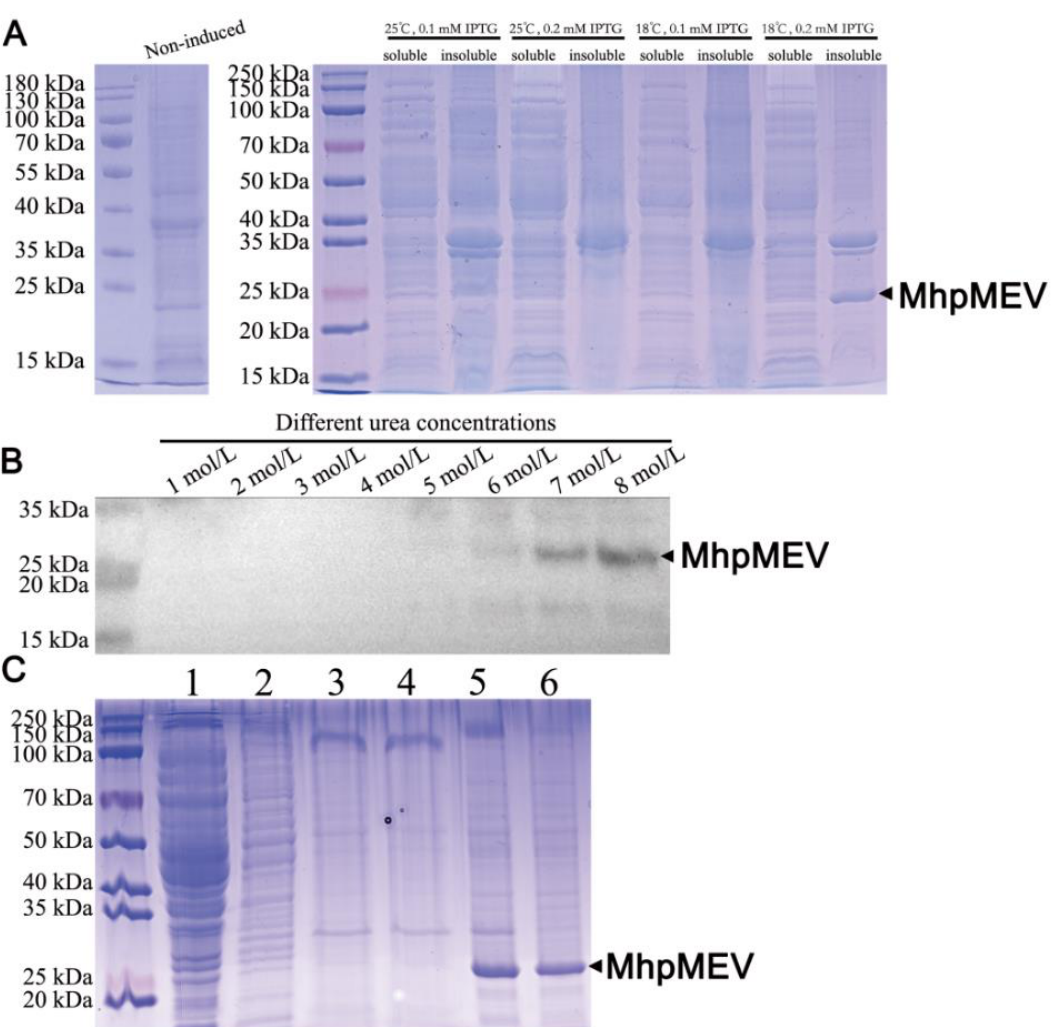
Figure 4. Protein expression and inclusion body refolding. ( A ) The expression results of MhpMEV in different induction conditions (Right); the non-induced cells were used as negative control (Left). The theoretical molecular weight of MhpMEV was 24.5 kDa, and the specific band could be obtained when incubated with 0.2 mM IPTG at 18 °C. ( B ) Western blotting analysis of MhpMEV with mouse monoclonal anti-His antibody. ( C ) SDS-PAGE analysis of the inclusion body washing and refolding. Lane 1: supernatant liquor after bacterial cell disruption; Lane 2: WB-I eluate; Lane 3: WB-II eluate; Lane 4: WB-I III eluate; Lane 5: 8 mol/L urea dissolving solution; Lane 6: supernatant liquor after